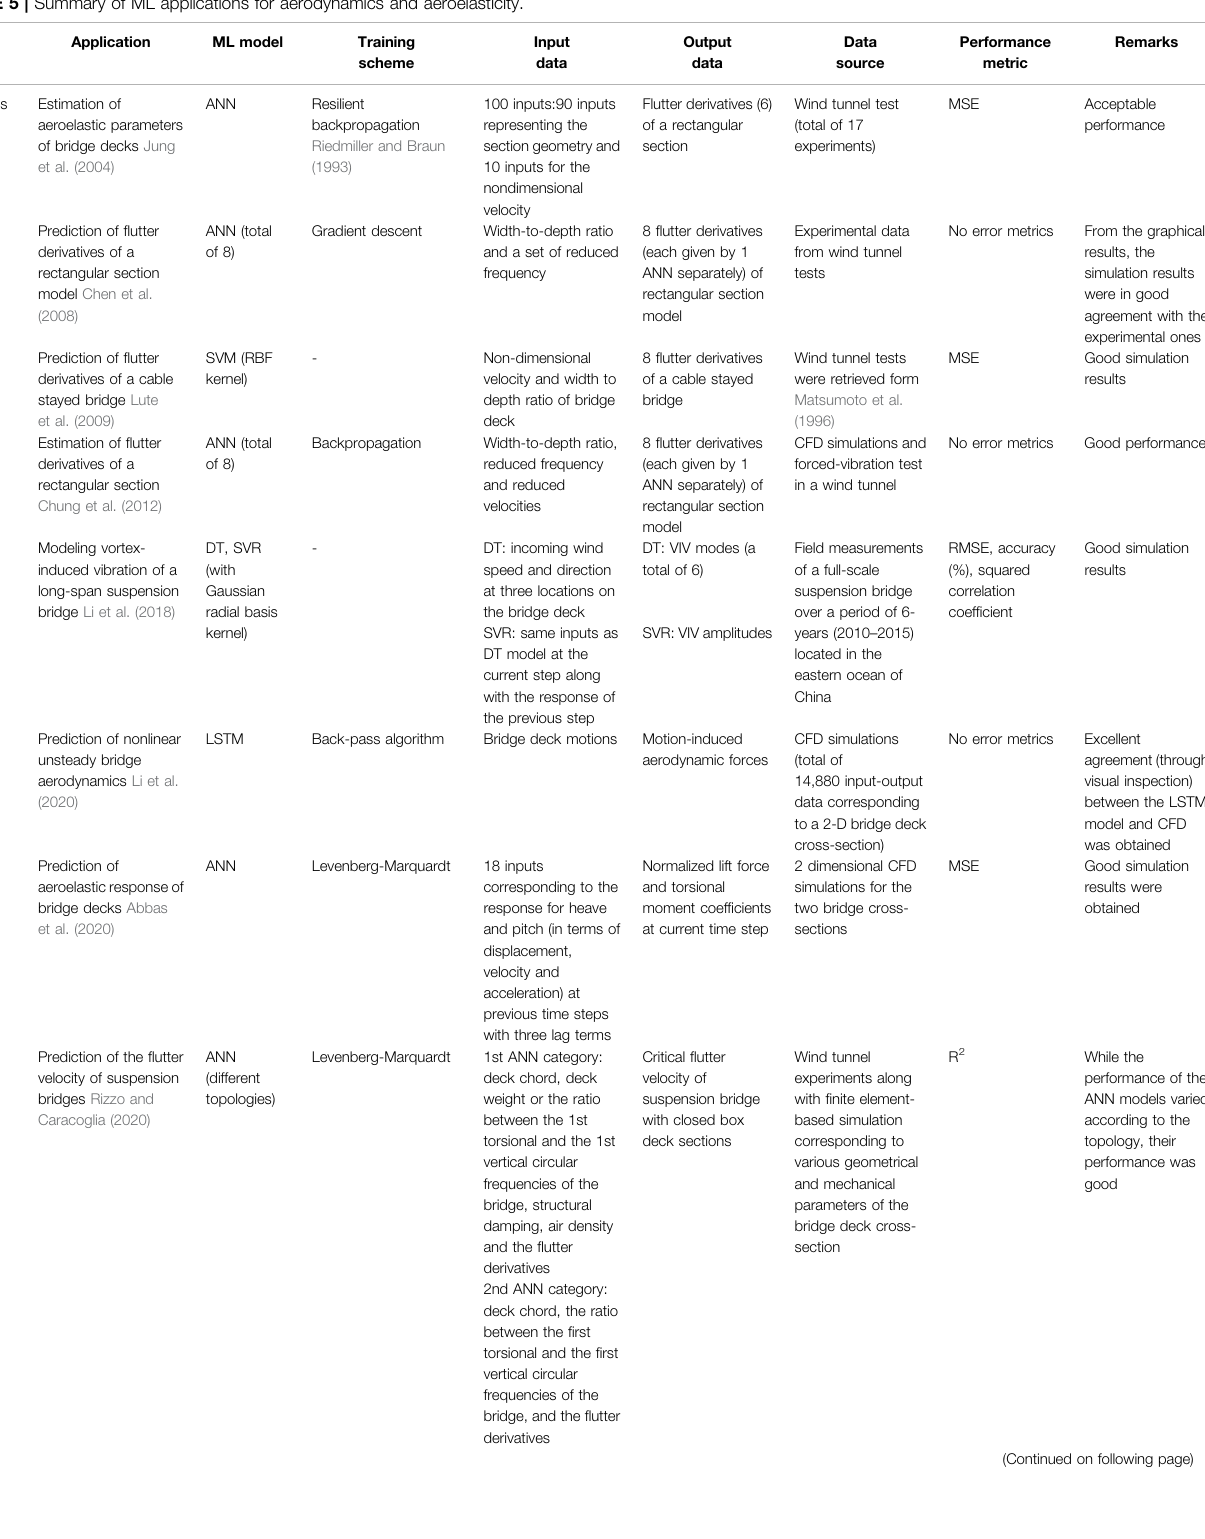
TABLE 5 | Summary of ML applications for aerodynamics and